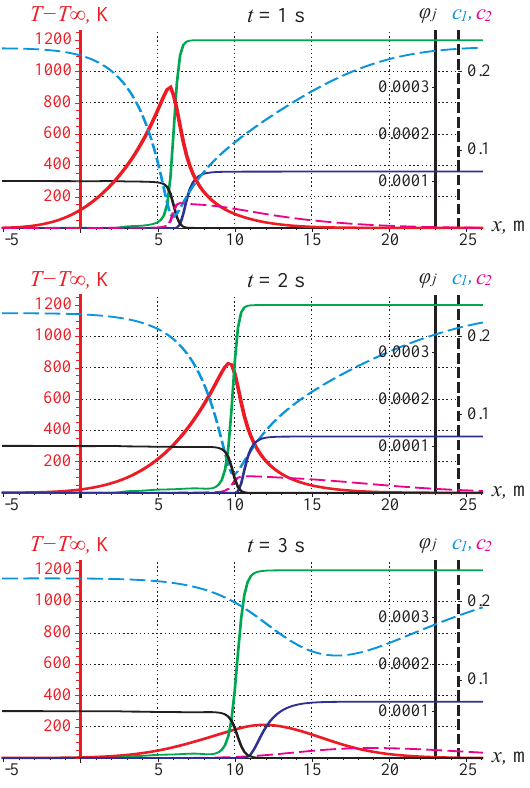
Figure 3. Typical distributions of characteristics of forest fire propagation at extinction scenario at moments of time t = 1 , 2 , 3 s.